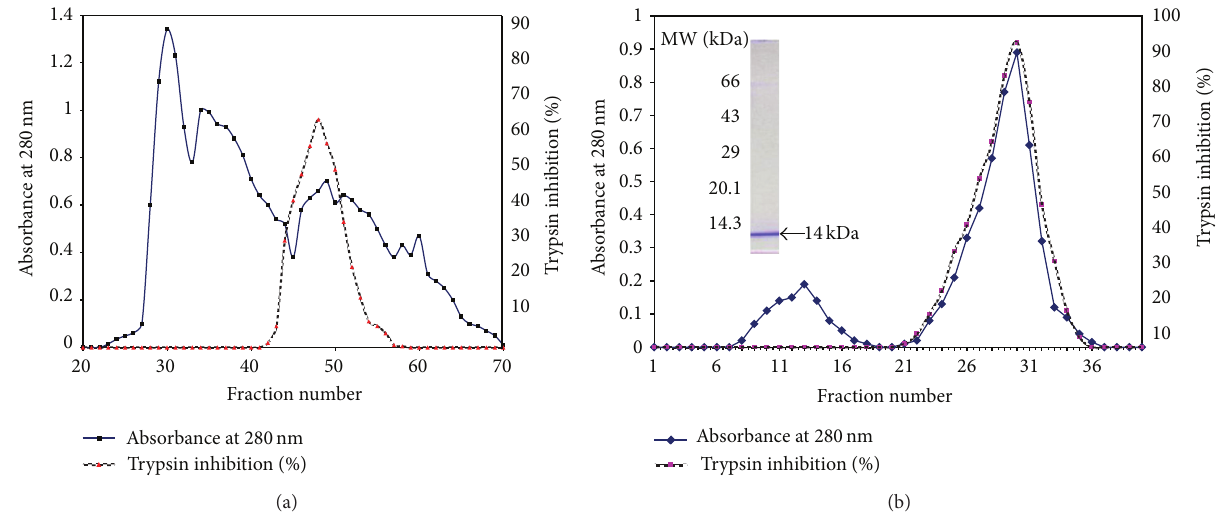
Figure 1: (a) Purification of BmPI using F 2 dialyzed fraction on Sephadex G-75. Each fraction collected through the column is of 4.5 mL at an initial flow rate of 0.3 mLmin −1 . (b) Trypsin affinity purification of BmPI using fractions (42–58) from Sephadex G-75 and protein profile on 12% SDS-PAGE under reducing conditions. The retained BmPI was eluted with 100mM HCl. Inset SDS-PAGE of pooled fraction (21 to 36): molecular weight markers are on the left and BmPI from trypsin affinity column chromatography are indicated on the